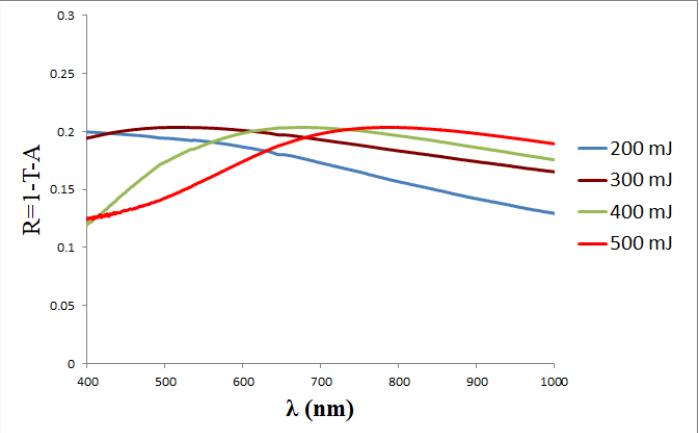
Fig.6: Reflectivity R of PbS nanostructure deposited at different laser energies as a function of wavelength.